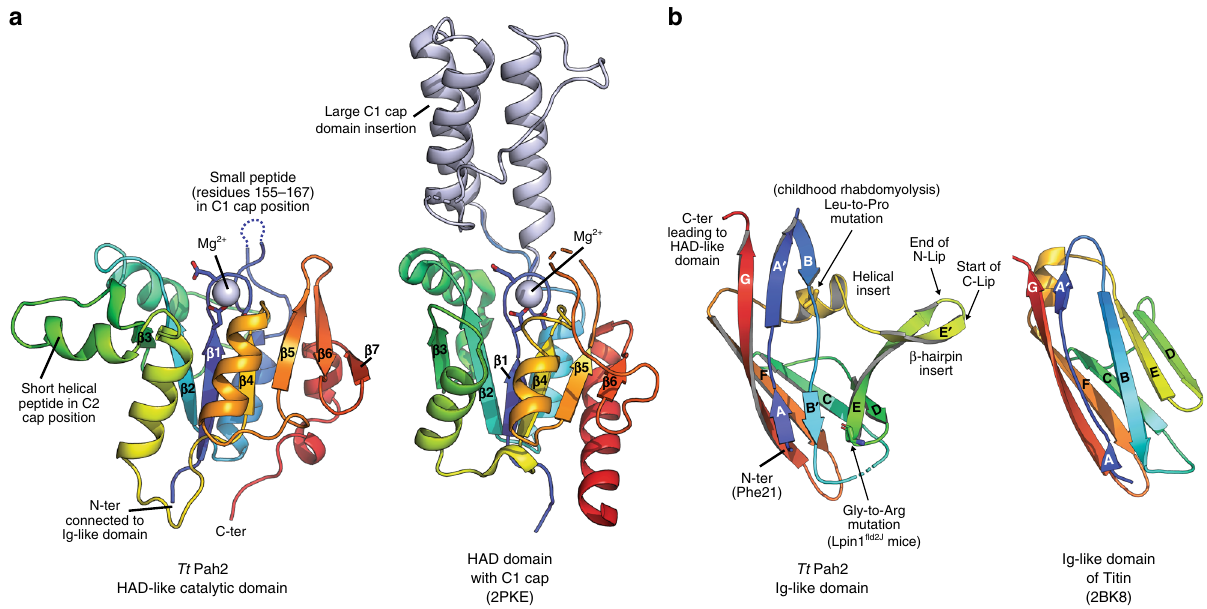
Fig. 2 Structural comparison of HAD and Ig domains with Tt Pah2. a Structural comparison of the Tt Pah2 HAD-like domain with a C1-type capped member of the HAD superfamily. The Tt Pah2 HAD-like domain is capless with two short peptides in lieu of large cap domain insertions to allow close association with membranes. Magnesium ions are shown as light blue spheres. b The Ig-like domain of Tt Pah2 forms an atypical Ig-like β -sandwich fold with the β E-strand at the end of the N-Lip splaying outward and forming a β -hairpin with the β E ′ strand at the start of the C-Lip. A helical insert follows, which contains a conserved Leu residue that is mutated in patients with childhood rhabdomyolysis packing into a hydrophobic core. The conserved glycine residue mutated in Lpin1 fl d2J mice is located at the beginning of β E-strand. The more typical Ig-like fold of the muscle protein Titin is shown for comparison with the β -strands labeled A – G.